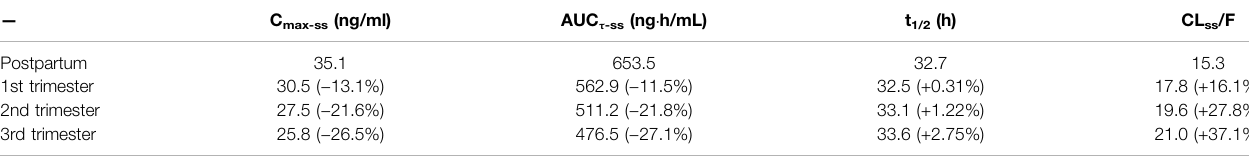
TABLE 5 | Model-predicted steady state pharmacokinetic parameters of olanzapine during pregnancy under 10 mg daily dose. Data shown as geometric means. —